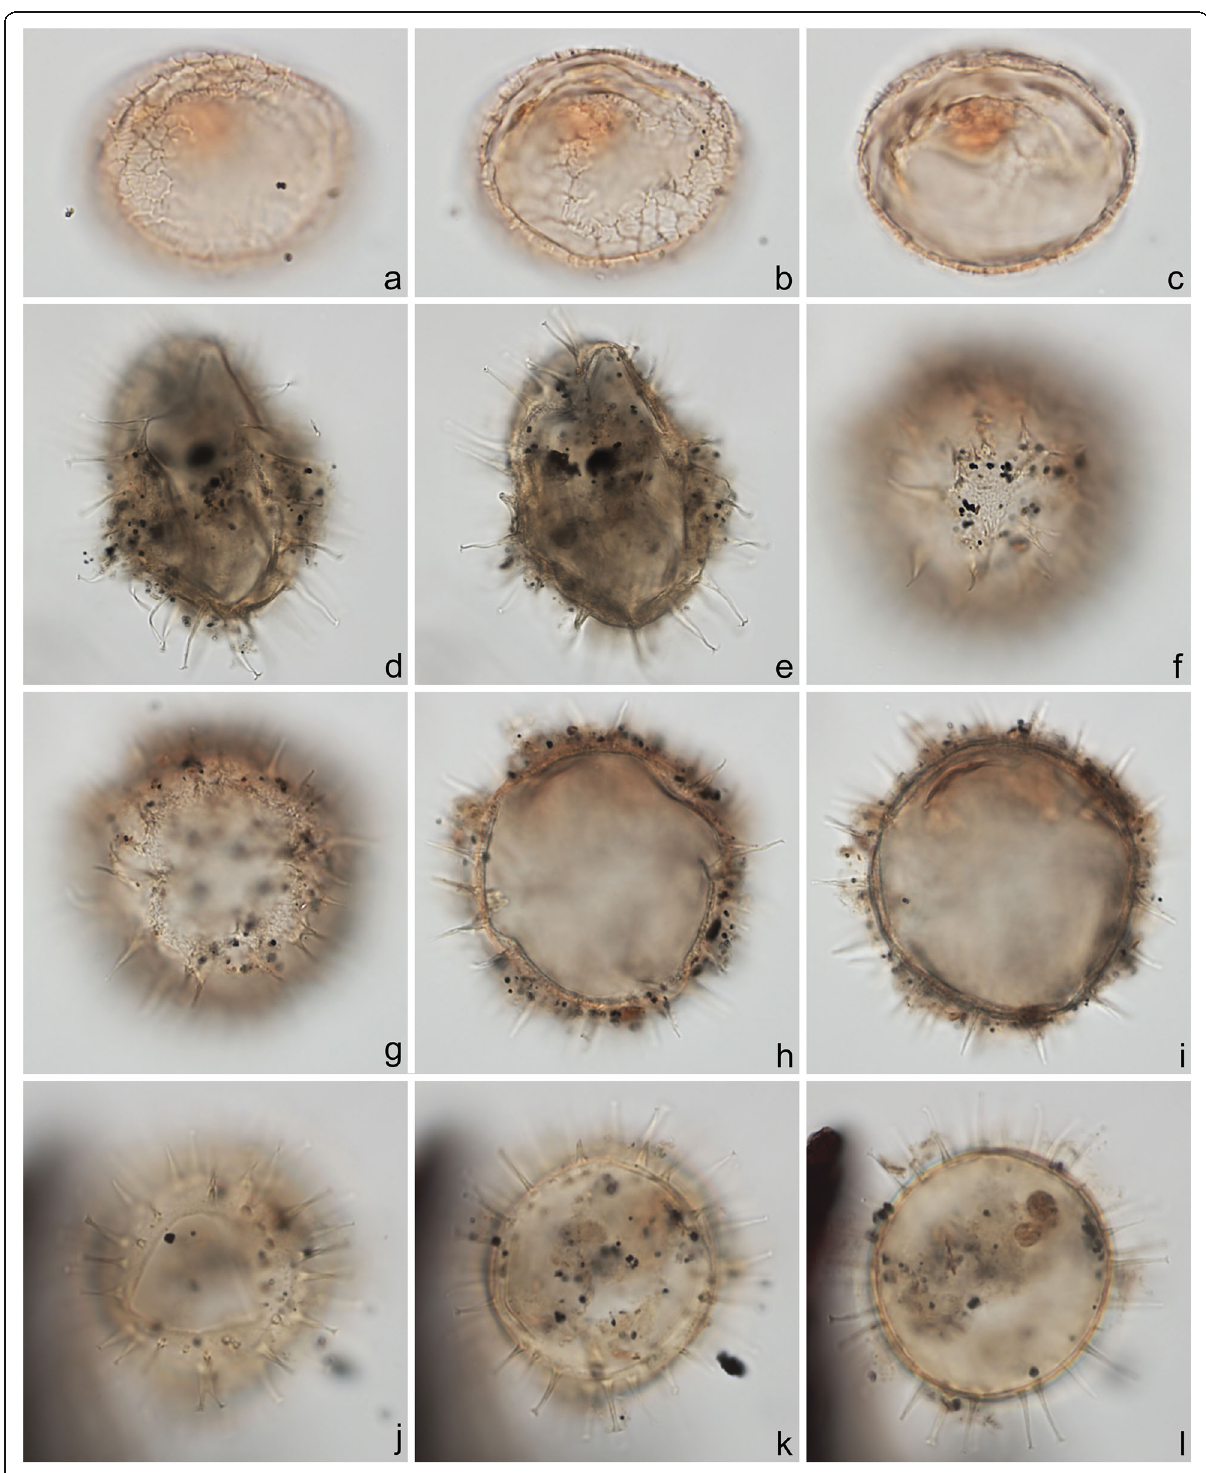
Fig. 8 (See legend on next